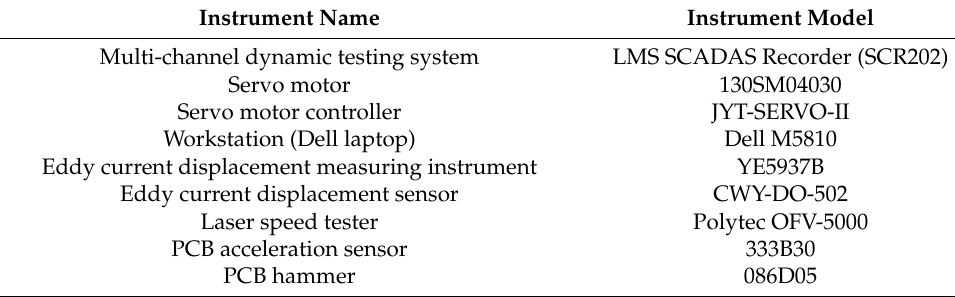
Table 5. Experimental equipment.